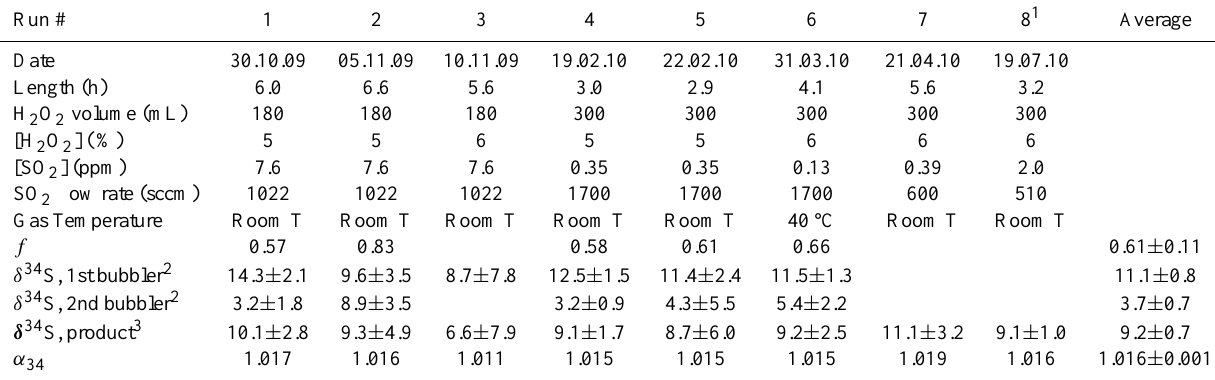
Table 2. Fractionation of 34 S/ 32 S during collection of SO 2 in a solution of 6 % H 2 O 2 . Run #